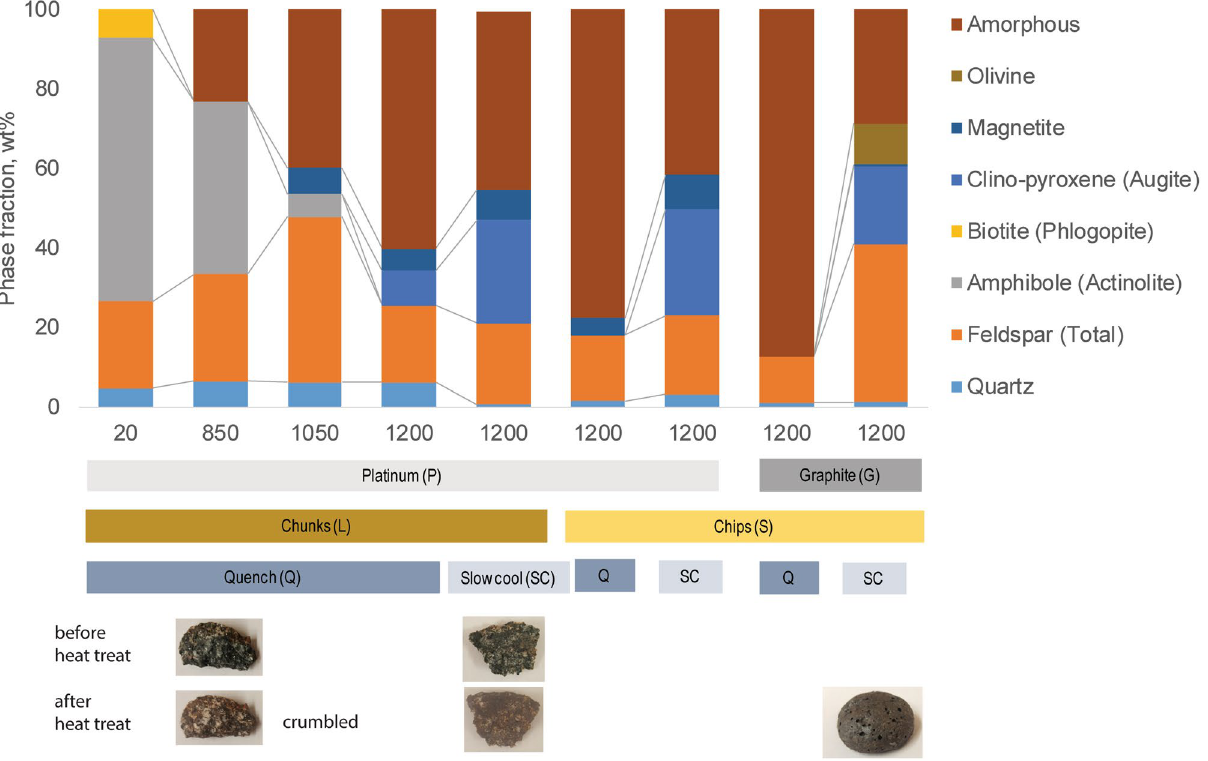
Figure 5. Ex situ XRD quantitative phase analysis of heat-treated amphibolite rock (BA5). Separate samples were heated to peak temperatures—20 °C (room temperature), 850 °C, 1050 °C, 1200 °C—and soaked for 15 min. Different experimental conditions were: crucibles (Pt or graphite), particle sizes (chunk or chip), and cooling conditions (quench or slow cool). Some representative photos of the samples are shown. Lines show some important